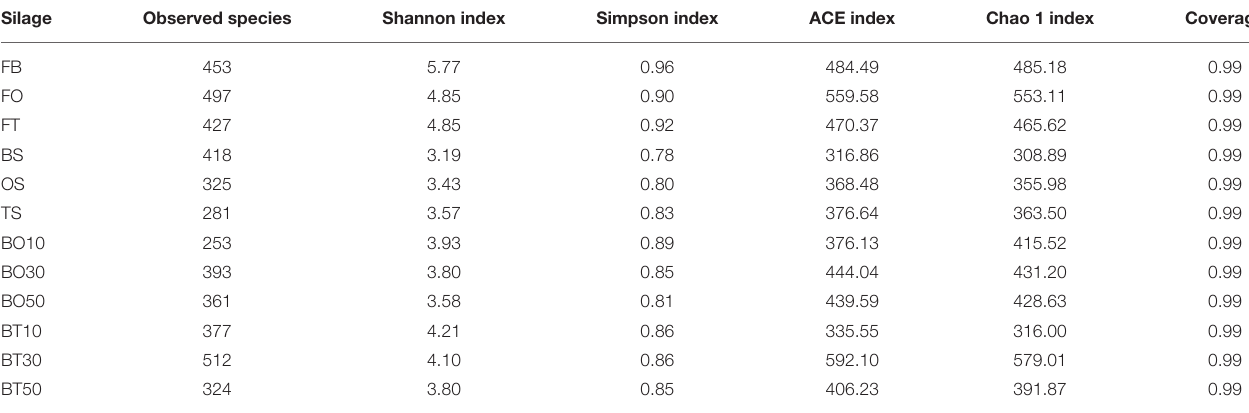
TABLE 5 | General information of bacterial diversity. Silage